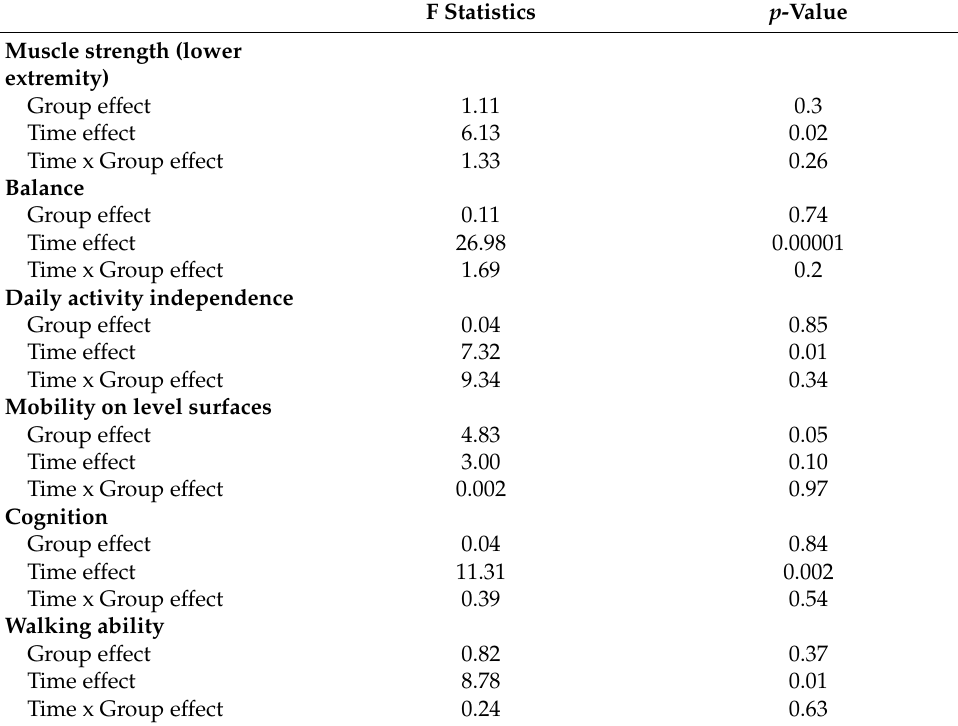
Table 3. The effect of time and group on the functional outcomes in Table